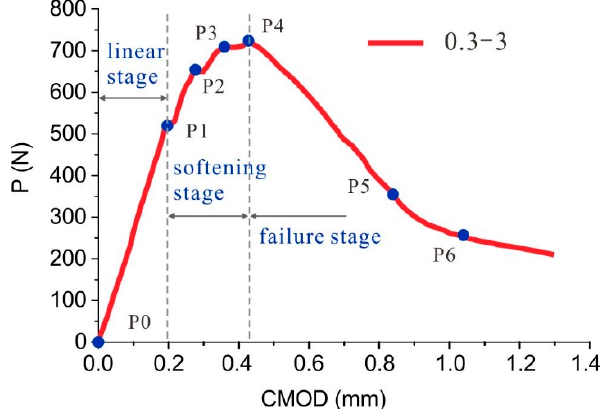
Figure 6. Three stages for typical P-CMOD curve of specimen 0.3-3.